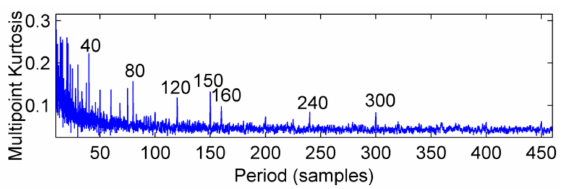
Figure 1. Simulation signal.